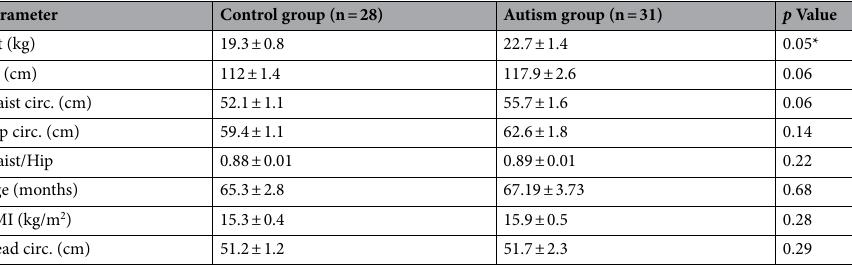
Table 1. Clinical characteristics of normal controls and subjects with autism. Abbreviations : N, number; Wt, weight; Ht, height; BMI, body mass index; Waist circ., waist circumference; Hip circ., hip circumference; Head